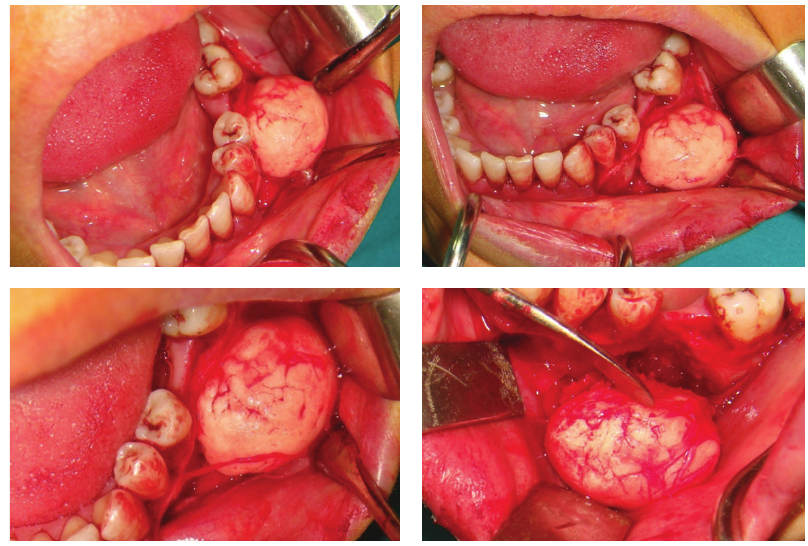
Figure 5: Mucoperiostal flap was removed and the entire lesion was found